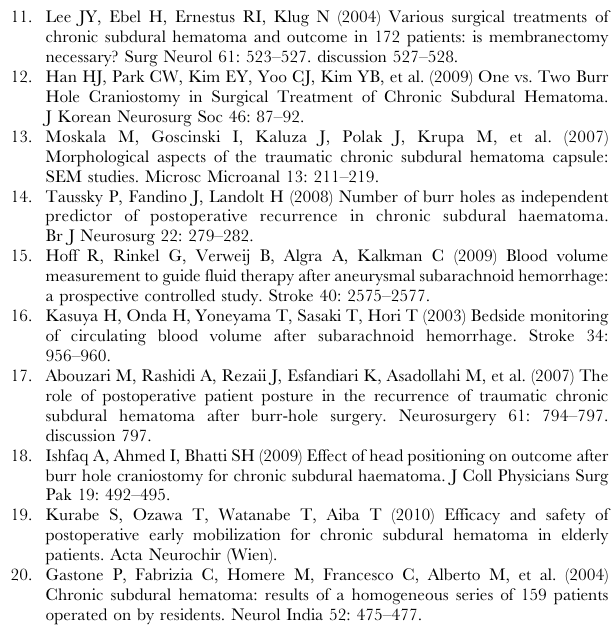
Table S1 Correlation analysis of independent variables. (DOC)